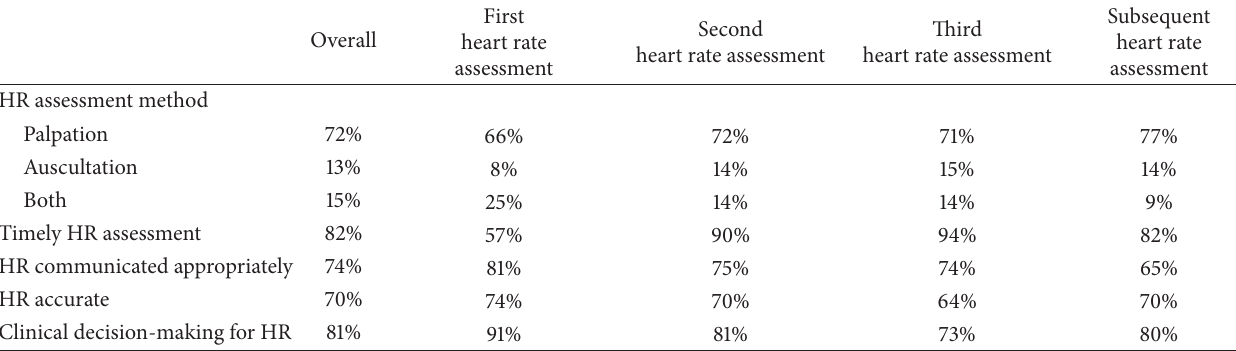
Table 2: House officers’ percentage of correct performance on heart rate (HR) assessments and clinical decision-making on neonatal high fidelity simulation resuscitations.